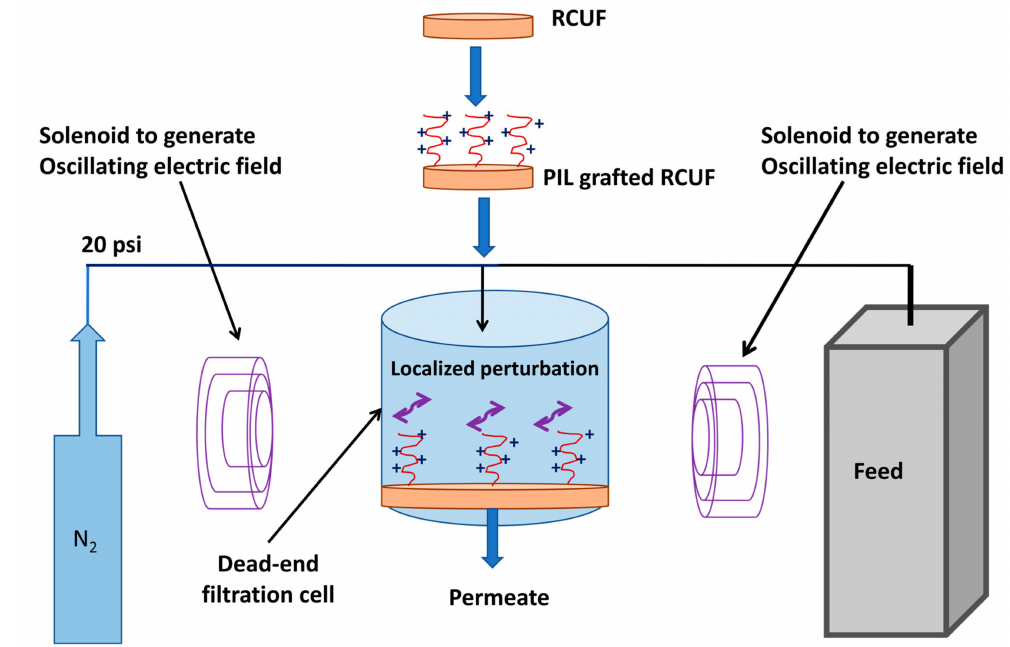
Figure 2. Schematic presentation of dead-end filtration set up for electric responsive